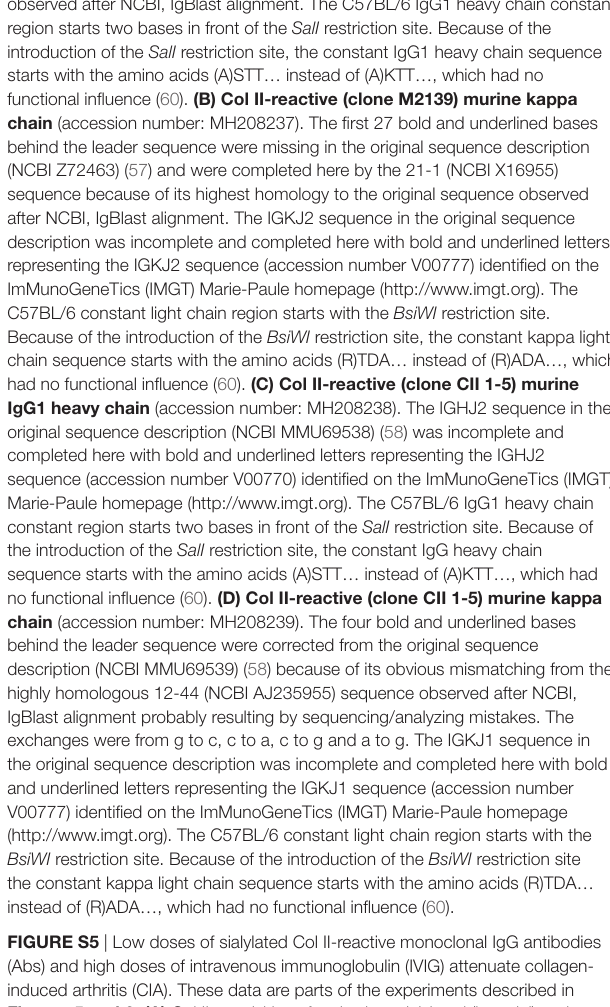
FigUre s6 | Application of sialylated antigen-specific murine IgG1 antibodies (Abs) enhances the development of antigen-specific Foxp3 + Tregs. (a)